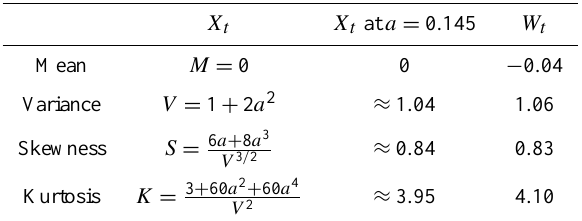
Table 1. Parameters of the model time series X t (Eq. 4) distribution vs. sample characteristics of the observed series W t in Fig. 1.